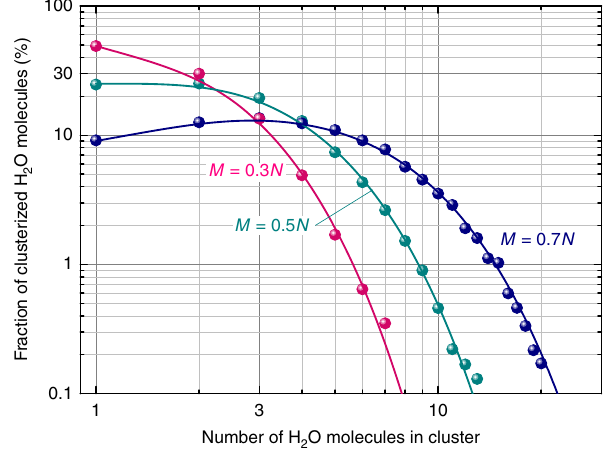
Figure 8 | Clustering of water molecules. Fraction of clustered water molecules versus the number of water molecules in a cluster. The calculations are done for different content of water molecules M relative to the number of cages N . The red dots and red line ( M ¼ 0.3 N ) correspond to the particular crystal studied here. The lines are calculated according to the expression (14), dots correspond to numerical